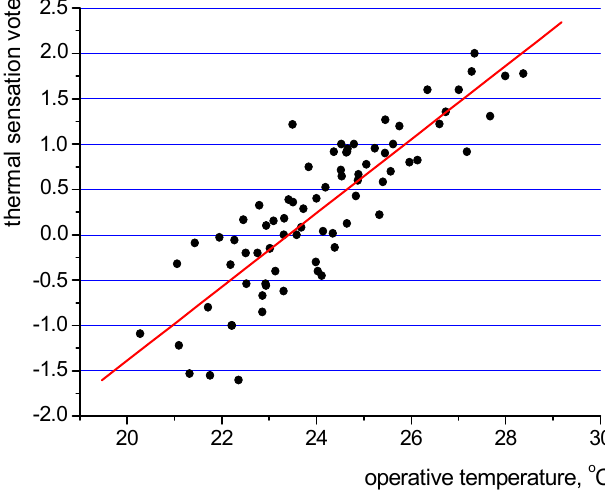
Figure 11. Relationship between average thermal sensation and operative temperature based on 1369 questionnaires.